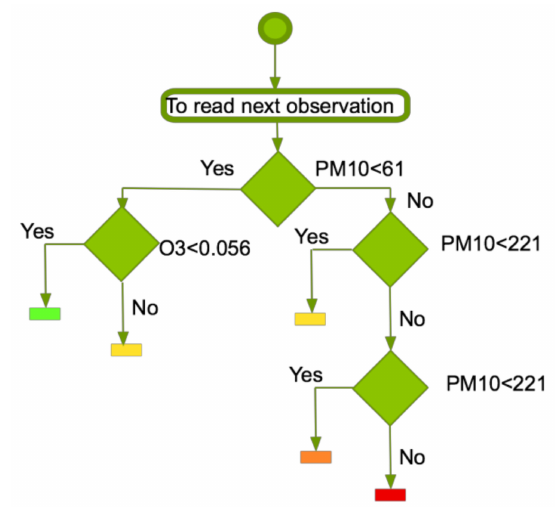
Figure 7. CART Algorithm from data